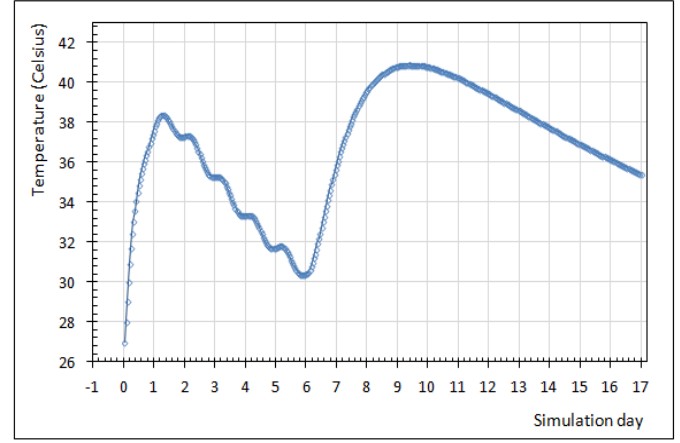
Figure 9. Temperature evolution in a node at the center of the